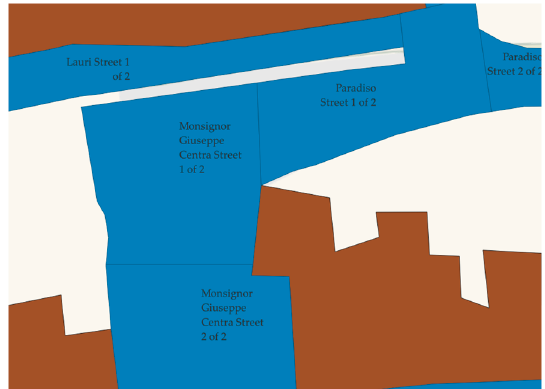
Figure 12. GIS visualization of some sample units of the Sampietrini network in Velletri.